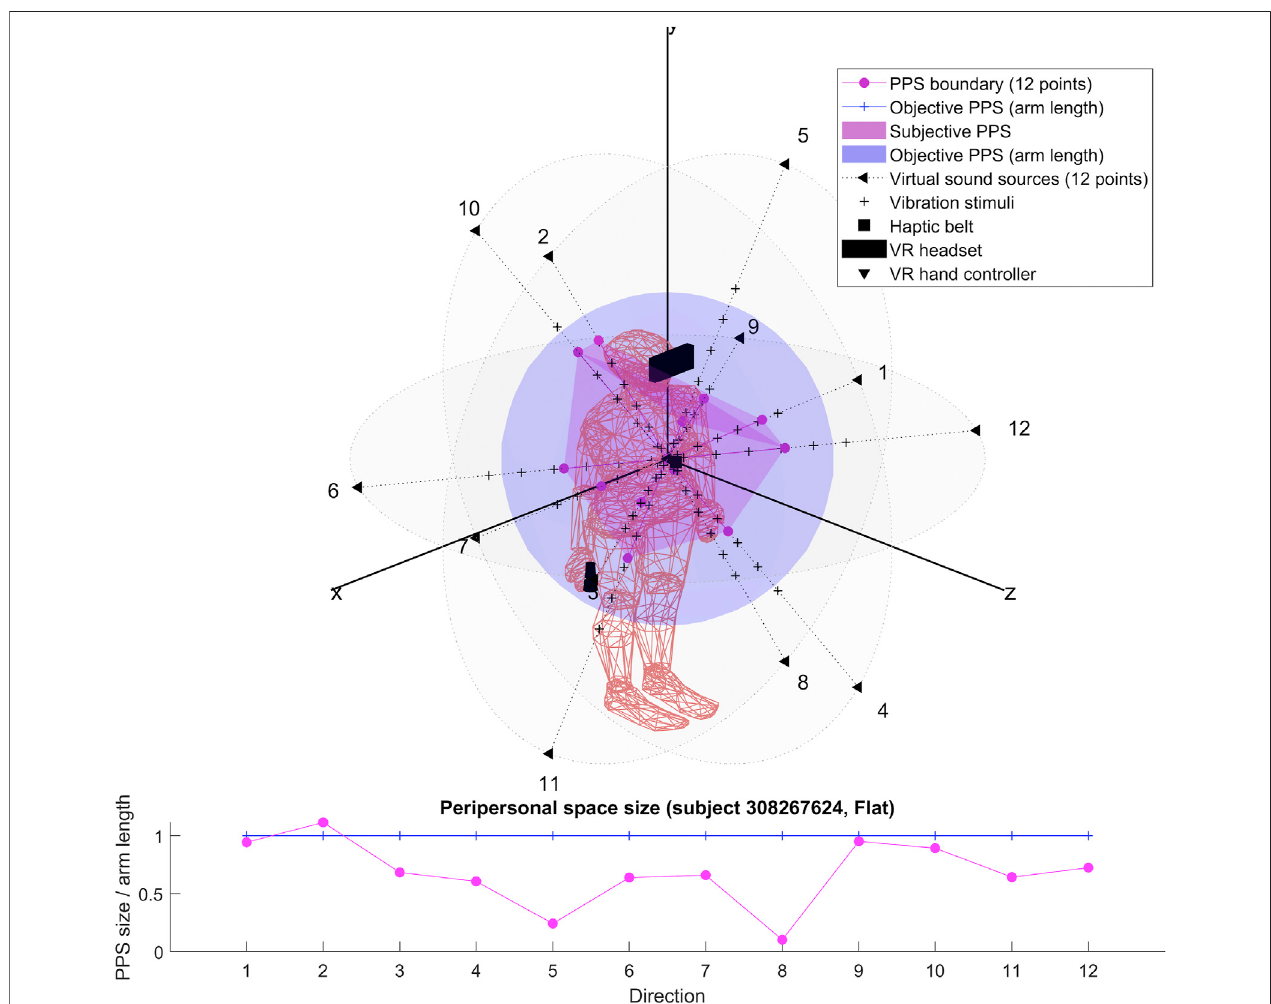
FIGURE 6 | PPS 3D representation for subject 308267624 fl at